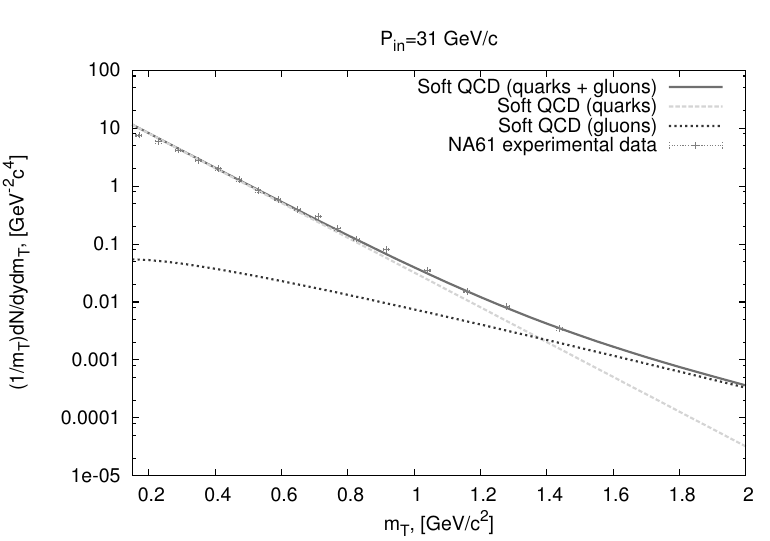
Figure 2. Results of the calculations of the inclusive cross-section of hadron production in pp collisions as function of transverse mass at the initial momenta P in = 31 GeV / c. They are compared to the NA61 experimental data from